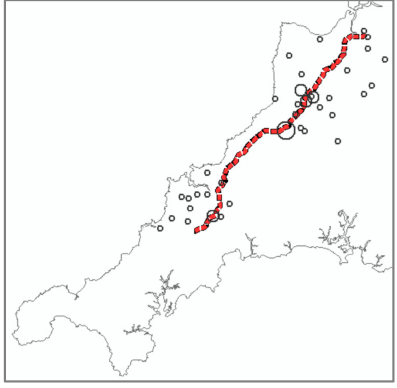
Figure 10. Solar farms and high voltage line in restricted Southwest